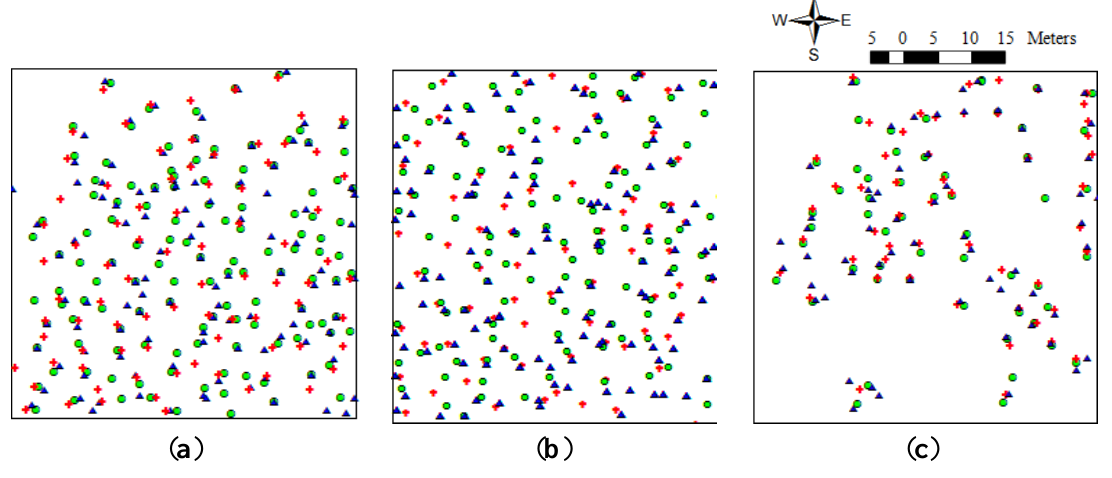
Figure 4. Comparisons of tree positions based on field measurement (red crosses) and positions extracted from the LiDAR-derived CHM using the VWF method (green points) and the IWS method (blue rectangles) for plot 1 ( a ), plot 2 ( b ), and plot 3 ( c